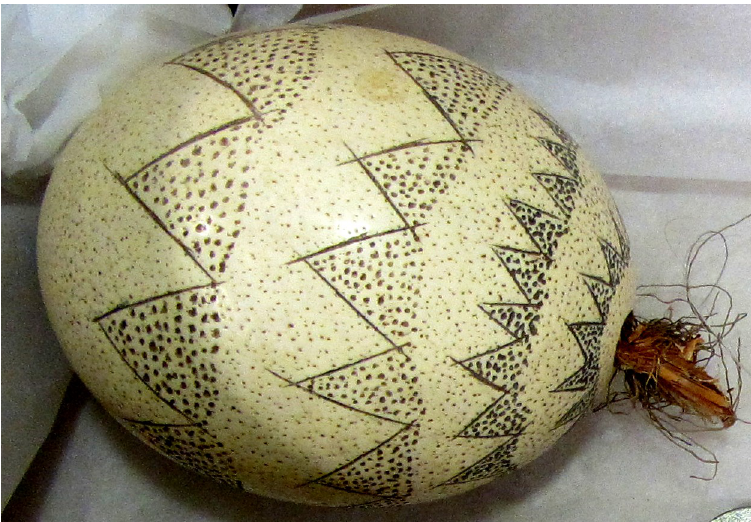
Fig 3. Examples of ethnographically recorded organic containers: A decorated ostrich eggshell made by Ghanzi farm Bushmen, Botswana, 1973 (Unaccessioned, Russell and Russell Kalahari Collection, University of the Witwatersrand, South Africa)